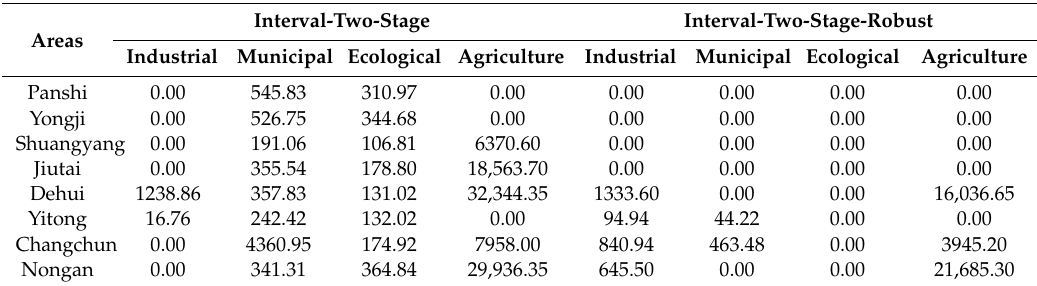
Table 10. The distribution scheme of reused water in the Yinma River Basin under di ff erent levels